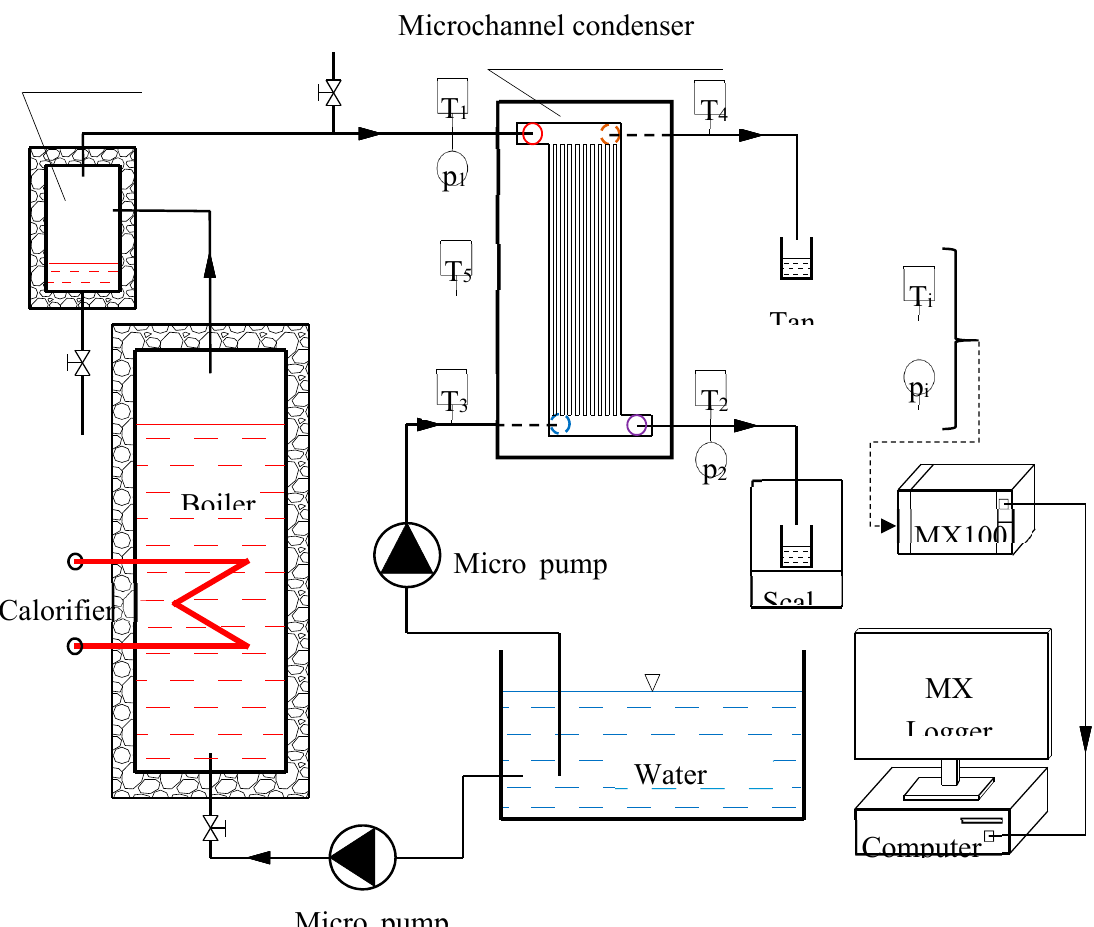
Figure 3. Schematic illustration of the experimental system.